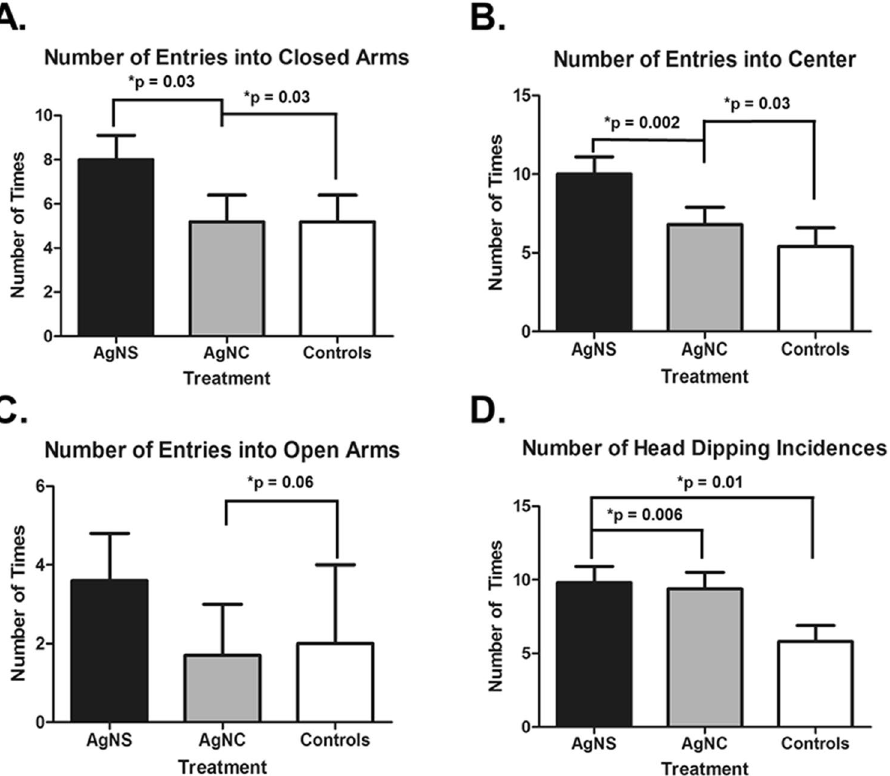
Figure 5. Elevated Plus Maze results. ( A ) Number of entries into the closed arms. ( B ) Number of entries into the center of the maze. ( C ) Number of entries into the open arms. ( D ) Number of head-dipping incidences. Significant results are indicated with bars and P values across the treatment